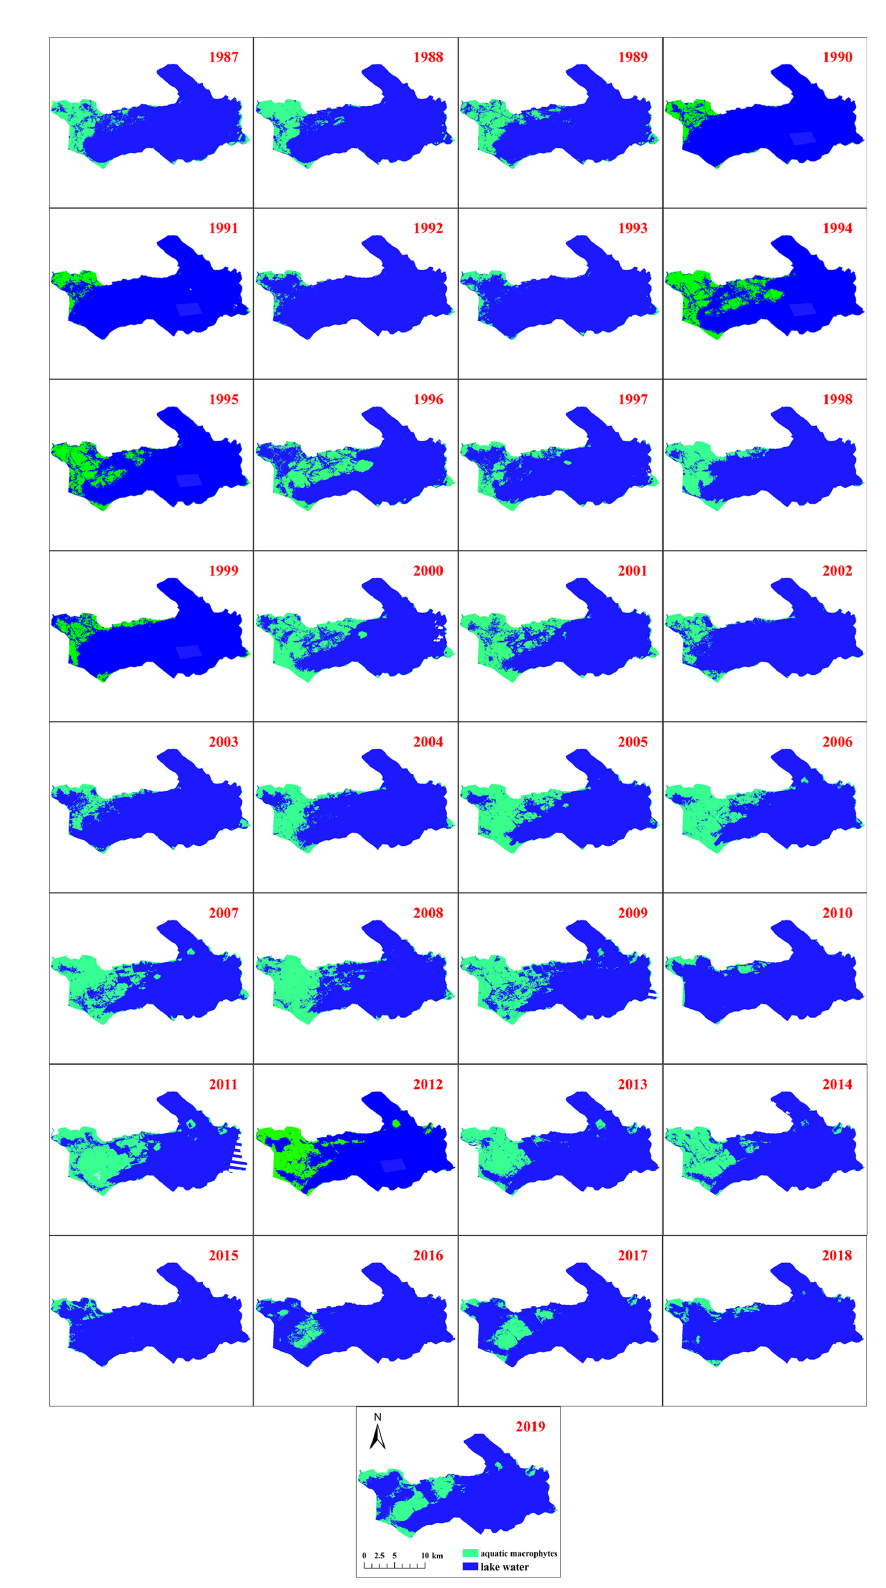
Figure 8. Spatial distribution map of aquatic vegetation in Longgan Lake from 1987 to